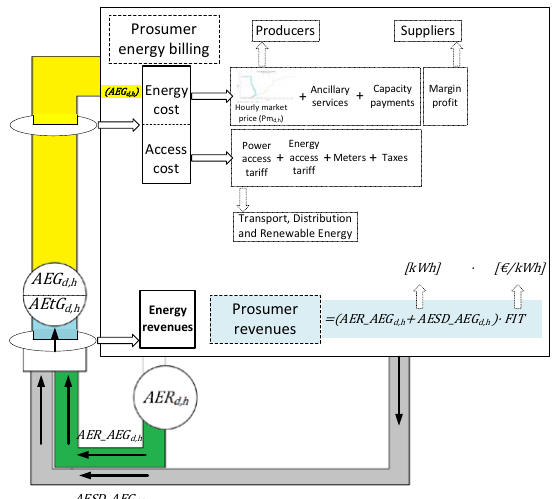
Figure 5. Representation of the prosumer’s billing subjected to the feed-in tariff (FiT) structure. Source: self-elaboration.